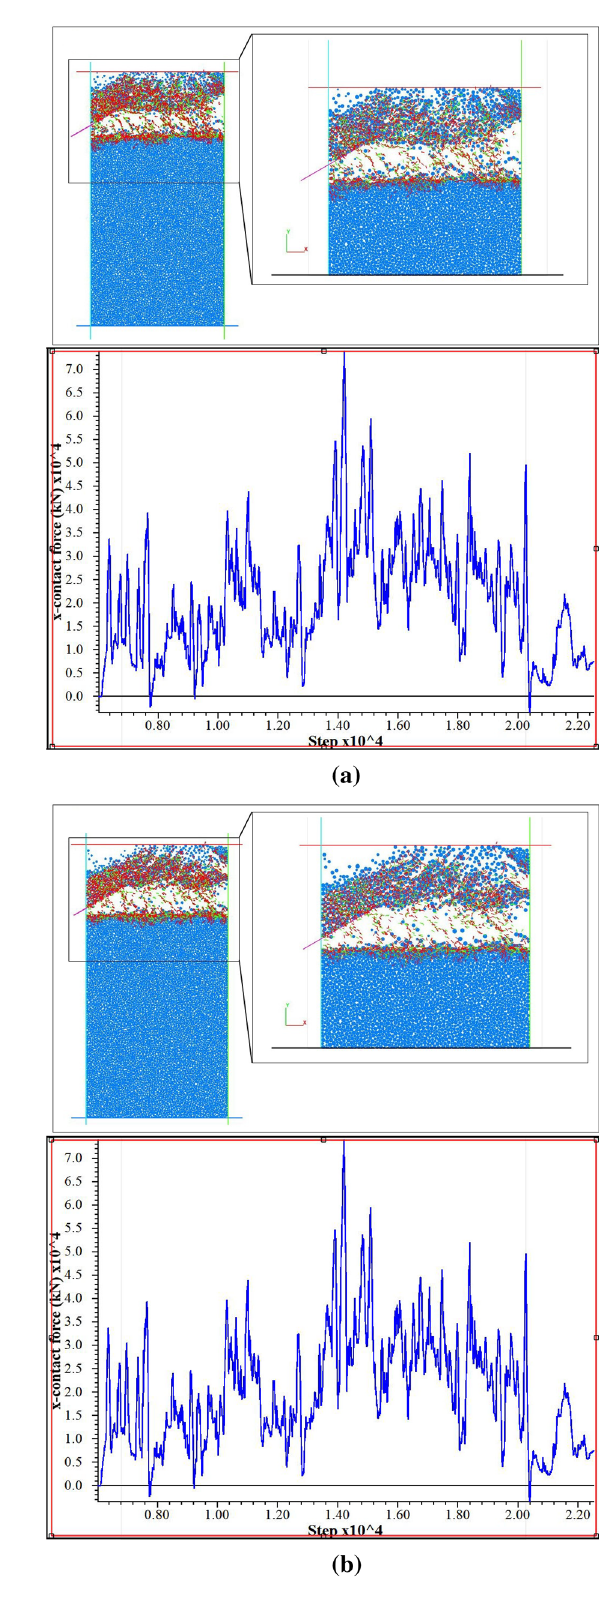
Fig. 11 Results of plow model with zero-degree angle: a Model 9, b Model 10